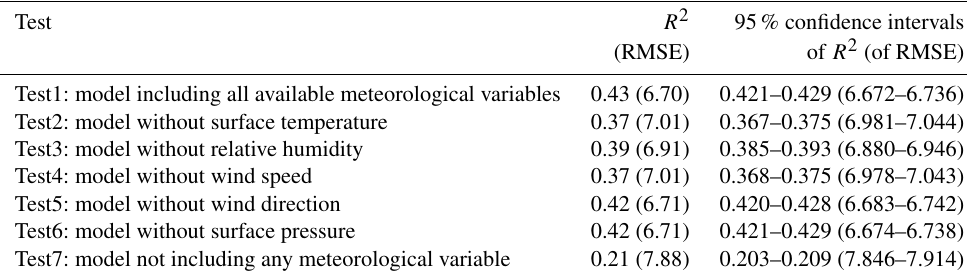
Figure 8. The number distribution of PM2.5/backscatter ratio for (a) daytime clear cases, (b) daytime cloudy cases and (c) nighttime cases. Table 3. Cross-validation tests of the model with different meteorological variables